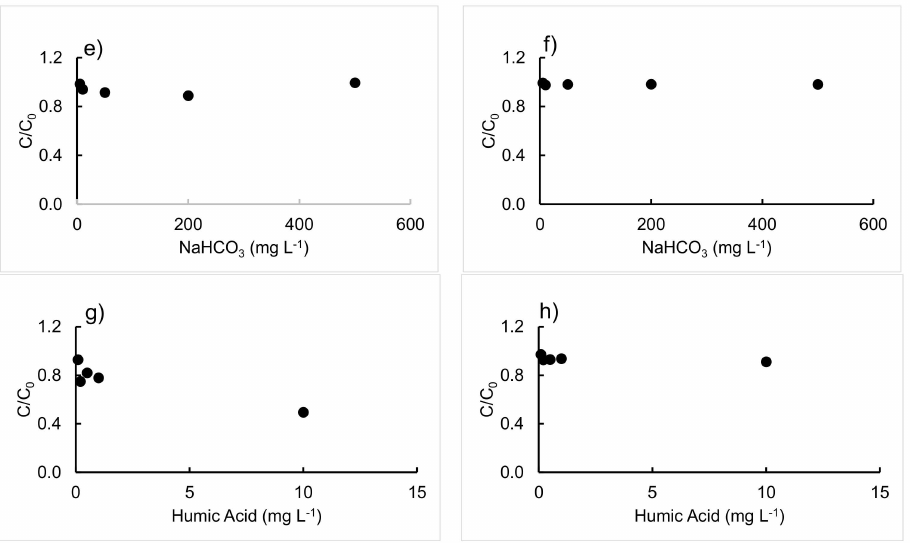
Figure 7. Sulfamethoxypyridazine (SMP) degradation under simulated sunlight and in the dark, in the presence of different salts or humic acids. ( a ) Presence of NaCl under simulated sunlight; ( b ) Presence of NaCl in the dark; ( c ) Presence of NaNO 3 under simulated sunlight; ( d ) Presence of NaNO 3 in the dark; ( e ) Presence of NaHCO 3 under simulated sunlight; ( f ) Presence of NaHCO 3 in the dark; ( g ) Presence of humic acids under simulated sunlight; ( h ) Presence of humic acids in the dark. Coefficients of variation were always lower than